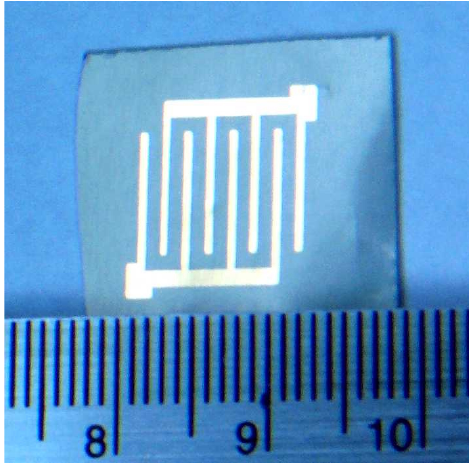
Figure 1. Digital image of a typical nanoporous alumina sensor.